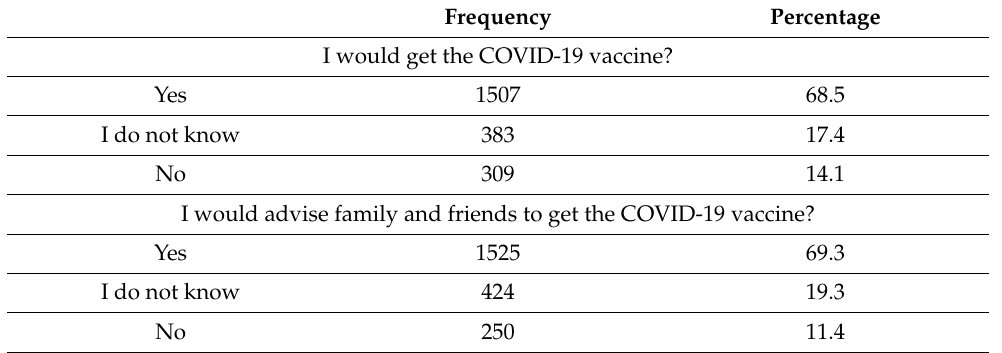
Table 6. Participants acceptance of COVID-19